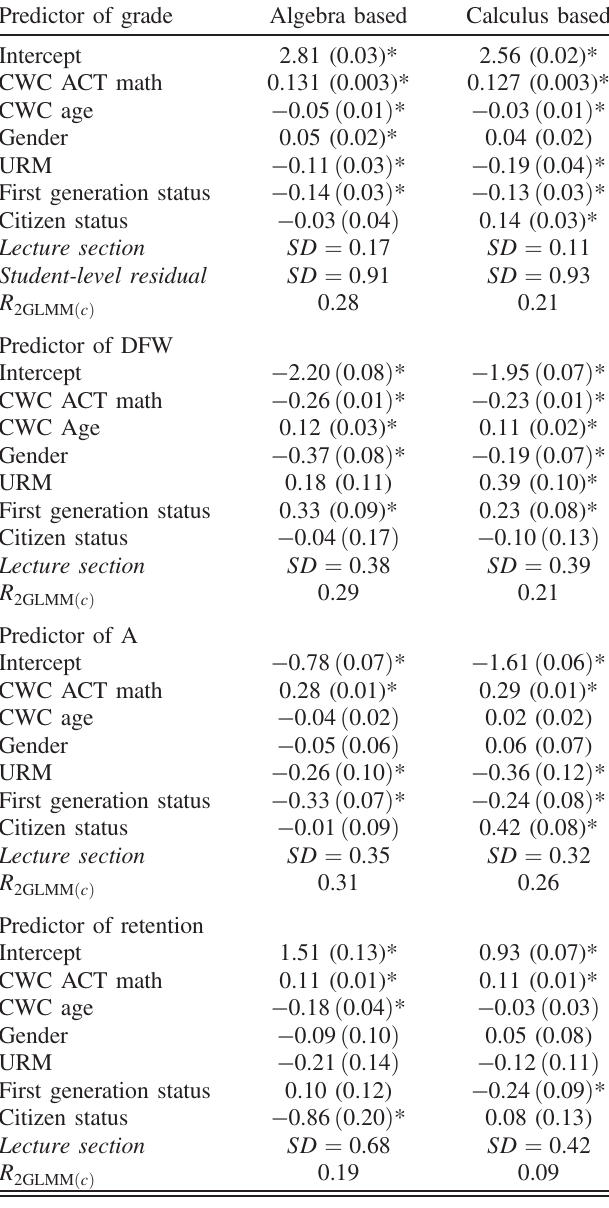
TABLE II. Nonstandardized multilevel model fixed effects estimates with standard errors reported in parentheses. A sig- nificance of p < 0 . 05 is indicated by *. The random effect of lecture section and its standard deviation are reported in